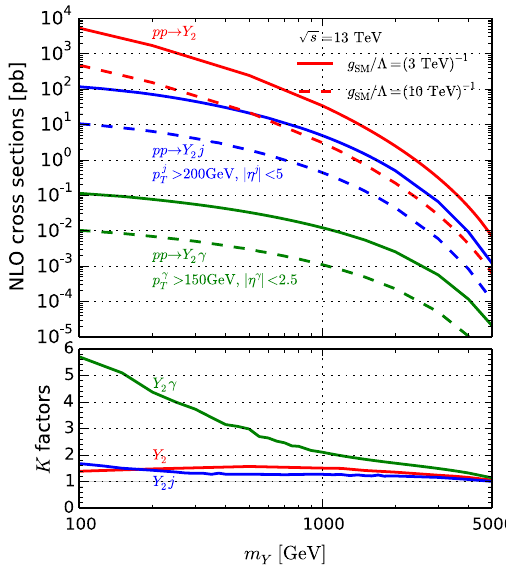
Fig. 3 Total cross sections at NLO accuracy for mediator productions at the 13 TeV LHC as a function of the mediator mass. Two choices of g SM /Λ are considered: ( 3 TeV ) − 1 shown as solid lines and ( 10 TeV ) − 1 shown as dashed lines . For Y 2 + jet cuts of p j areimposed,andfor Y 2 + photoncutsof p K factors are also shown in the lower panel as a reference